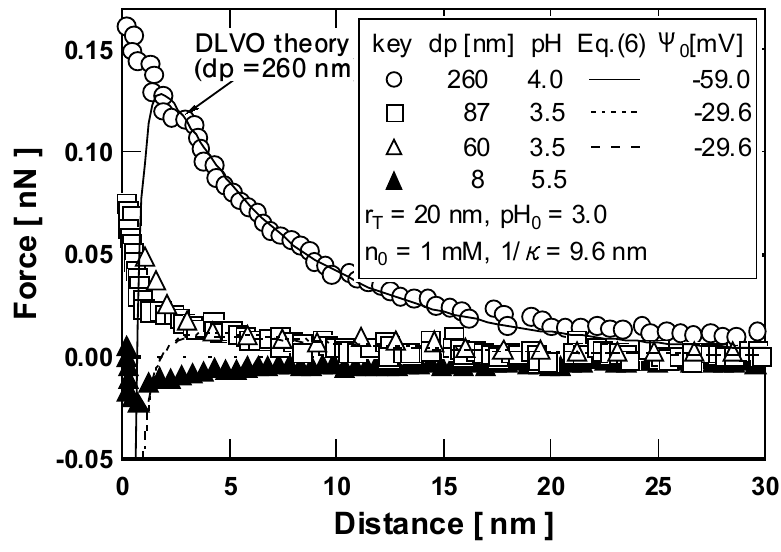
Fig. 3 Force curves between sol-gel derived SiO 2 particles with different particle diameter measured by colloid probe